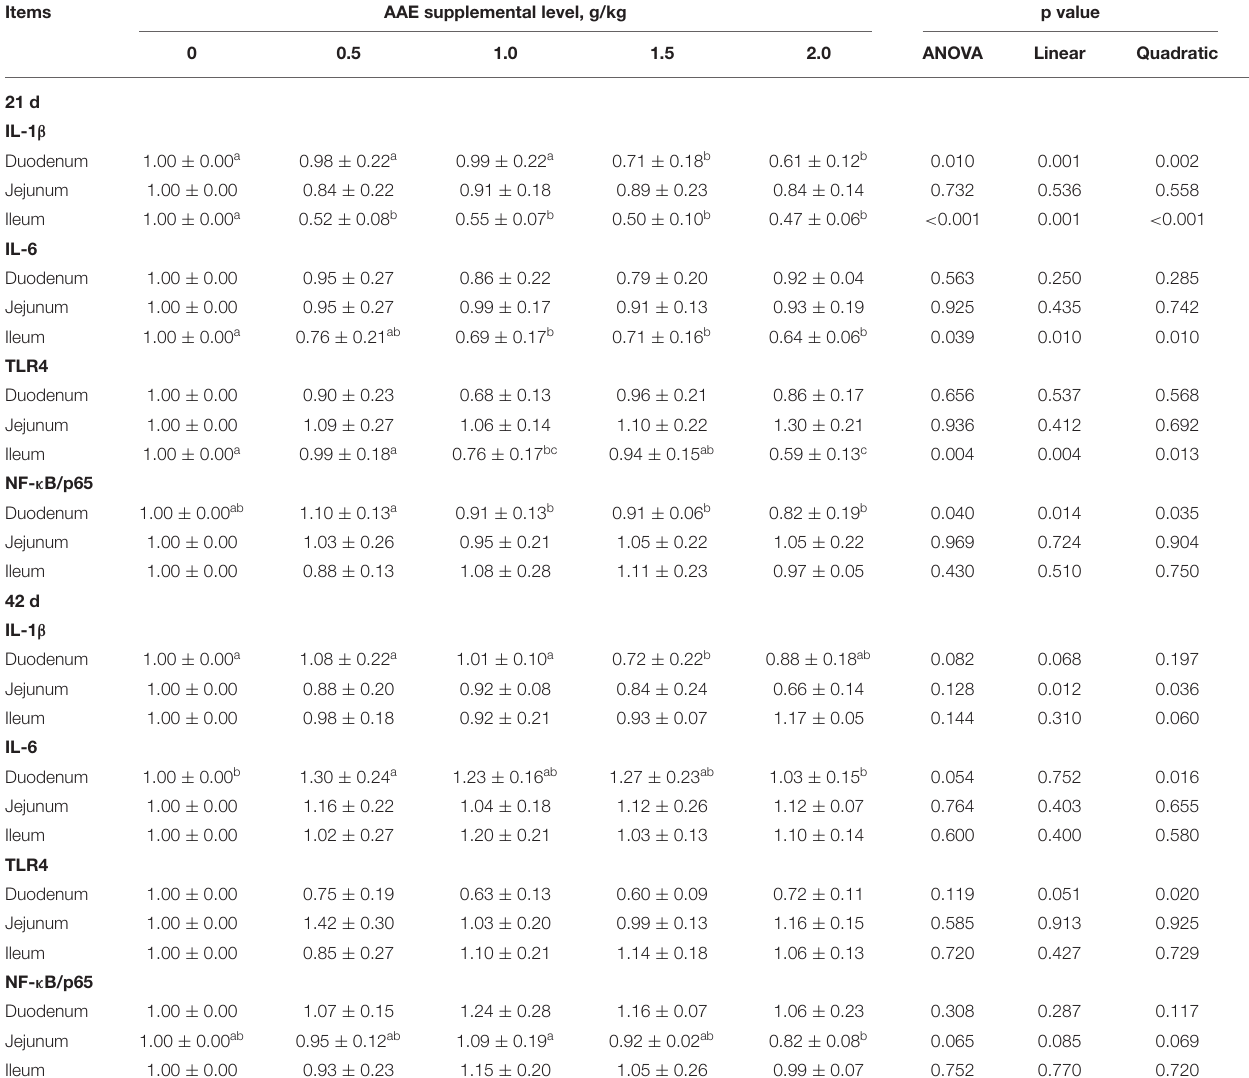
TABLE 7 | Effect of AAE on the expression of small intestinal immune-related genes in broilers.